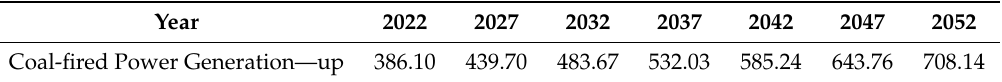
Table 9. Consumption bounds for coal-fired power generation in the ISTBUS scenario